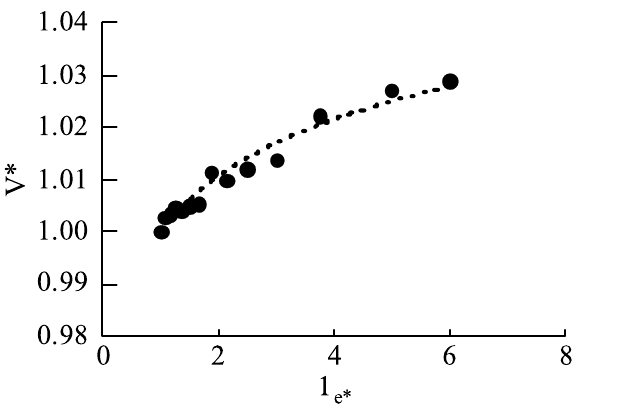
Figure 12. V* and σe * matrix